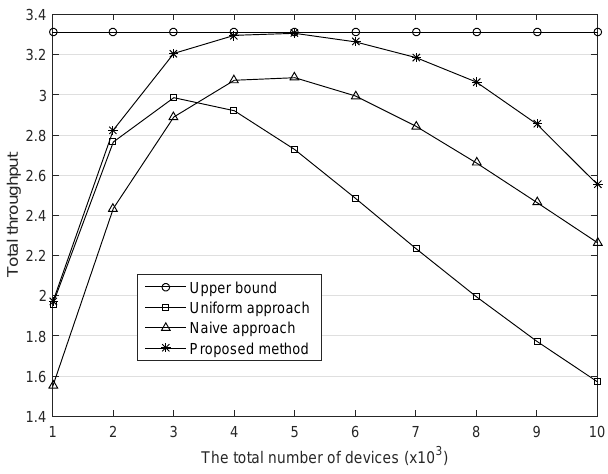
Figure 7. The comparison of the total throughput. The packet length is 100 byte.